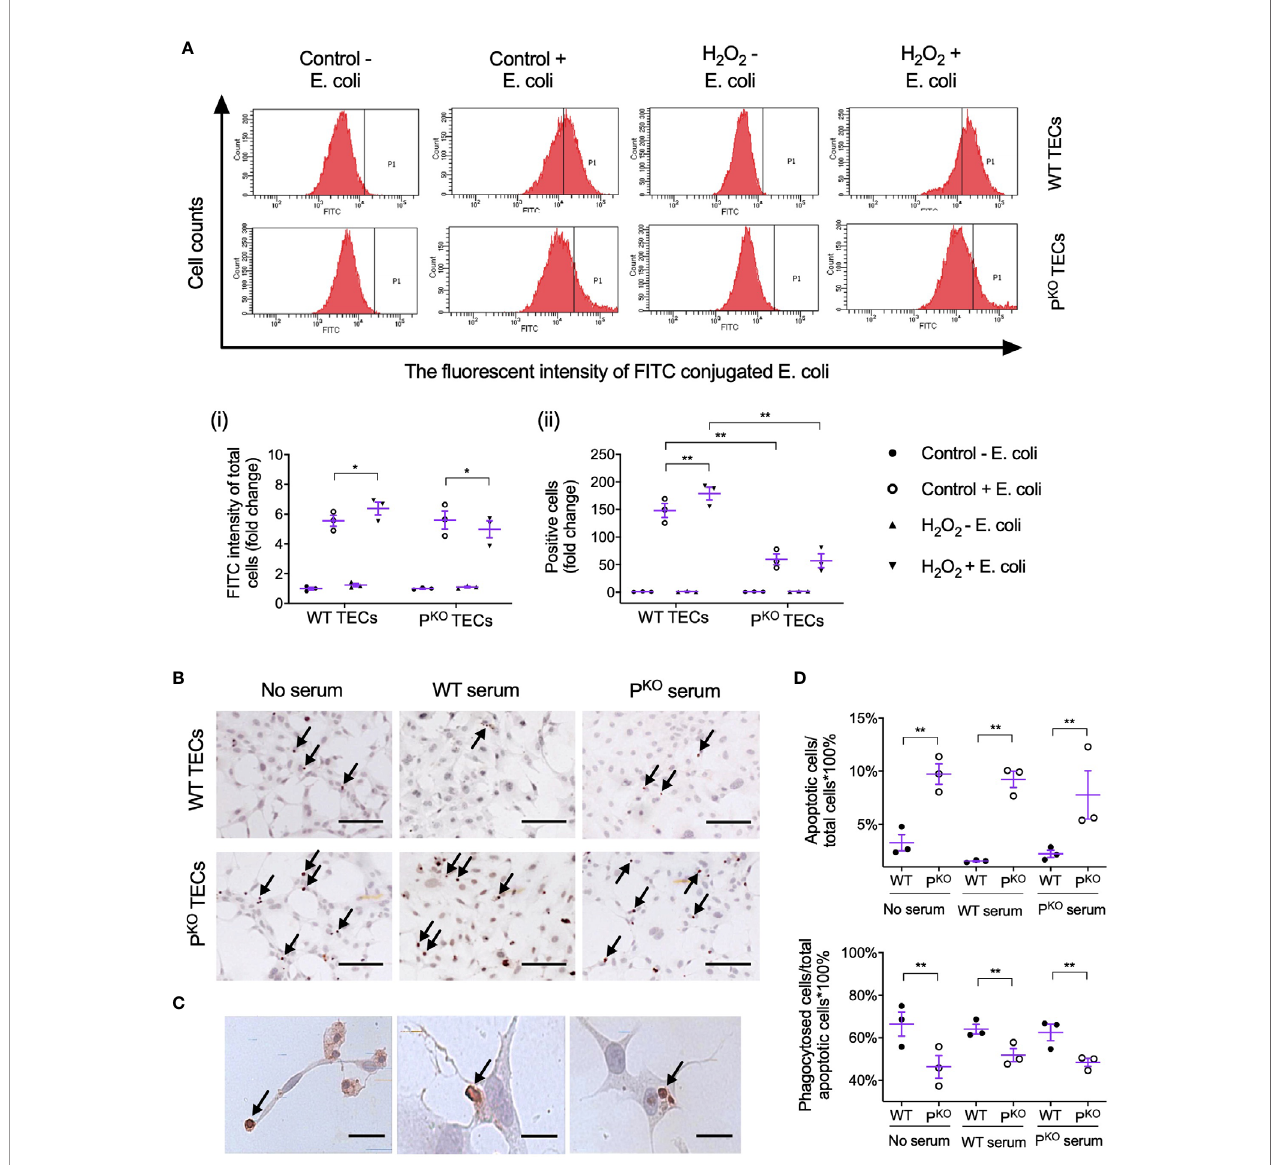
FIGURE 7 | Properdin contributes to the phagocytic ef fi cacy of primary isolated TECs. (A) Flow cytometry analysis of phagocytosed FITC-labeled E. coli by primary isolated WT and P KO TECs with or without H 2 O 2 treatment for 24 h (n = 3). The fl uorescent intensity of FITC conjugated E. coli re fl ected the phagocytic function of TECs. (i) The fold change of the average intensity of FITC fl uorescence among total cells, calculated against the control ( − E. coli ) group, was increased in WT TECs but decreased in P KO TECs by H 2 O 2 . (ii) The fold change of E. coli positive cell counts (P1 area) in each group against the control ( − E. coli ) group was increased in WT TECs by H 2 O 2 but stayed low in P KO TECs of either the control or H 2 O 2 groups compared to corresponding WT groups. (B) Representative images of apoptotic WT and P KO TECs detected by ISEL (ISEL+ cells indicated by arrows, n = 3). Scale bar: 50 m m. (C) Healthy WT TECs approaching, partially engul fi ng, and phagocytosing adjacent ISEL+ cells were demonstrated and indicated by arrows. Scale bar: 5 m m. (D) Semiquantitative analysis showed that the percentage of ISEL+ cells against the total number of cells was increased by P KO regardless of serum conditions, while the percentage of phagocytosed ISEL+ cells against the total number of ISEL+ cells was decreased by P KO after H 2 O 2 treatment for 24 h (n = 3). Data were shown as means ± SEMs and analyzed by one-way ANOVA and LSD test. * p < 0.05; ** p <